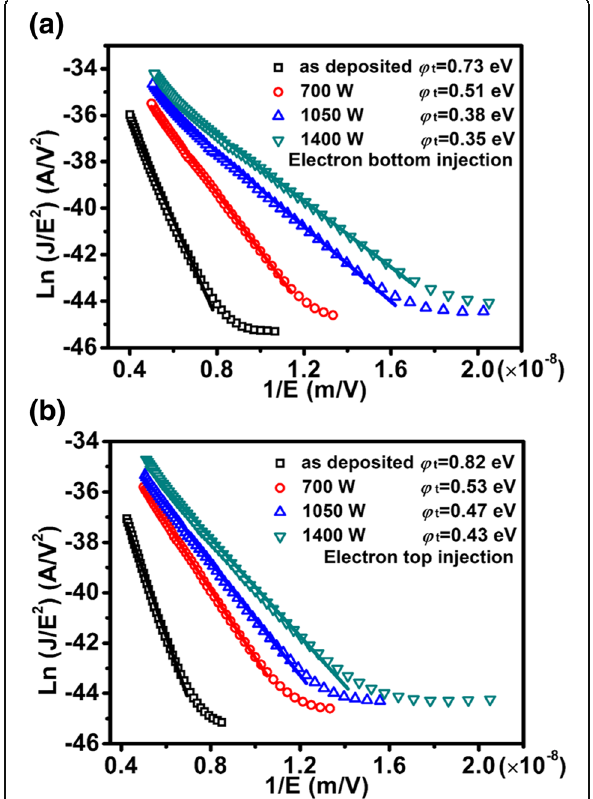
Fig. 5 The plot of Ln ( J / E 2 ) vs 1/ E for different samples. a Electron bottom-injection and b electron